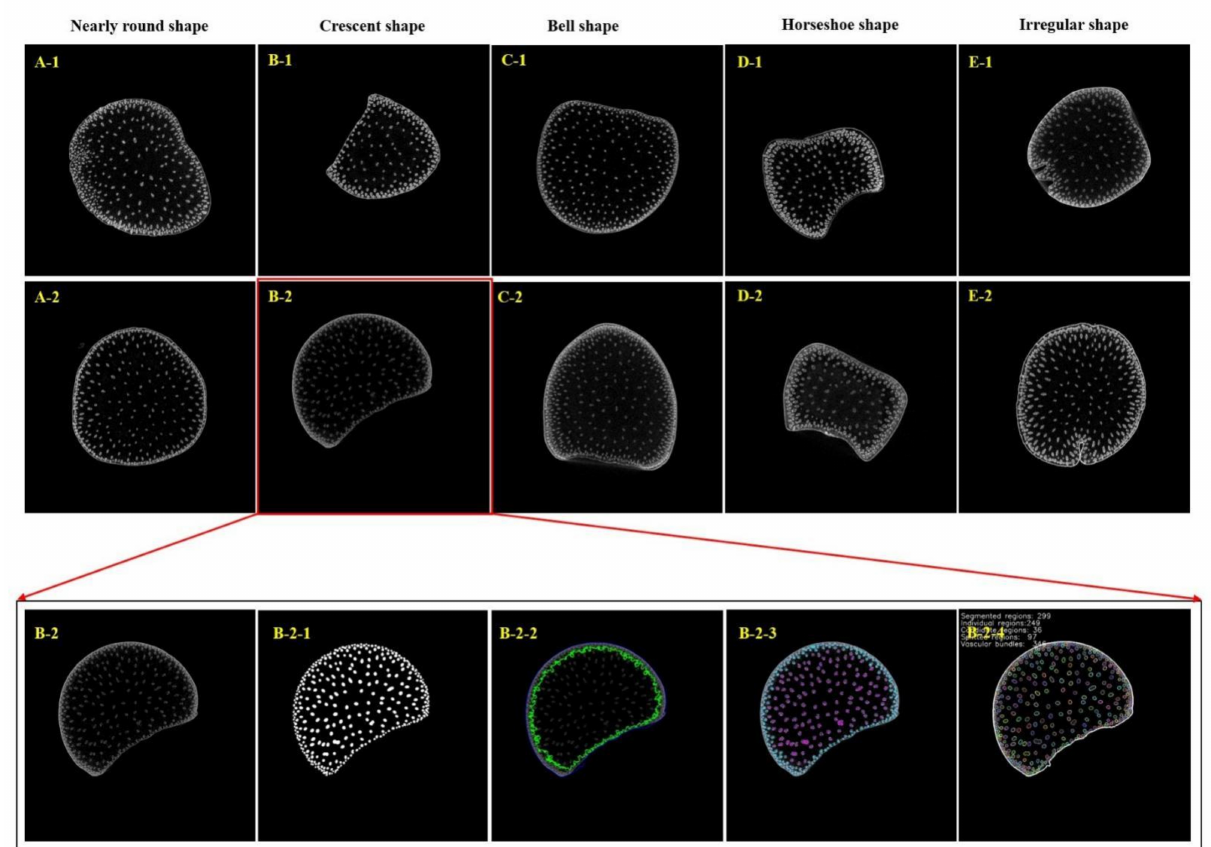
Figure 1. The shape variations of maize shank cross-sections. ( A1 , A2 ): Nearly round shape; ( B1 , B2 ) crescent shape; ( C1 , C2 ) bell shape; ( D1 , D2 ) horseshoe shape; ( E1 , E2 ) irregular shape). The image processing results for a maize shank cross-section. (( B2 ) Source image; ( B2-1 ) vascular bundle segmentation result; ( B2-2 ) the boundaries of the epidermis, periphery and inner zones (the blue line defines the boundary of the epidermis, and the green line segments the boundary between the periphery and inner zones); ( B2-3 ) classification of vascular bundles in different functional zones (blue represents the vascular bundles in the periphery zone, and rose red represents the vascular bundles in the inner zone; ( B2-4 ) vascular bundle labelling and phenotypic index